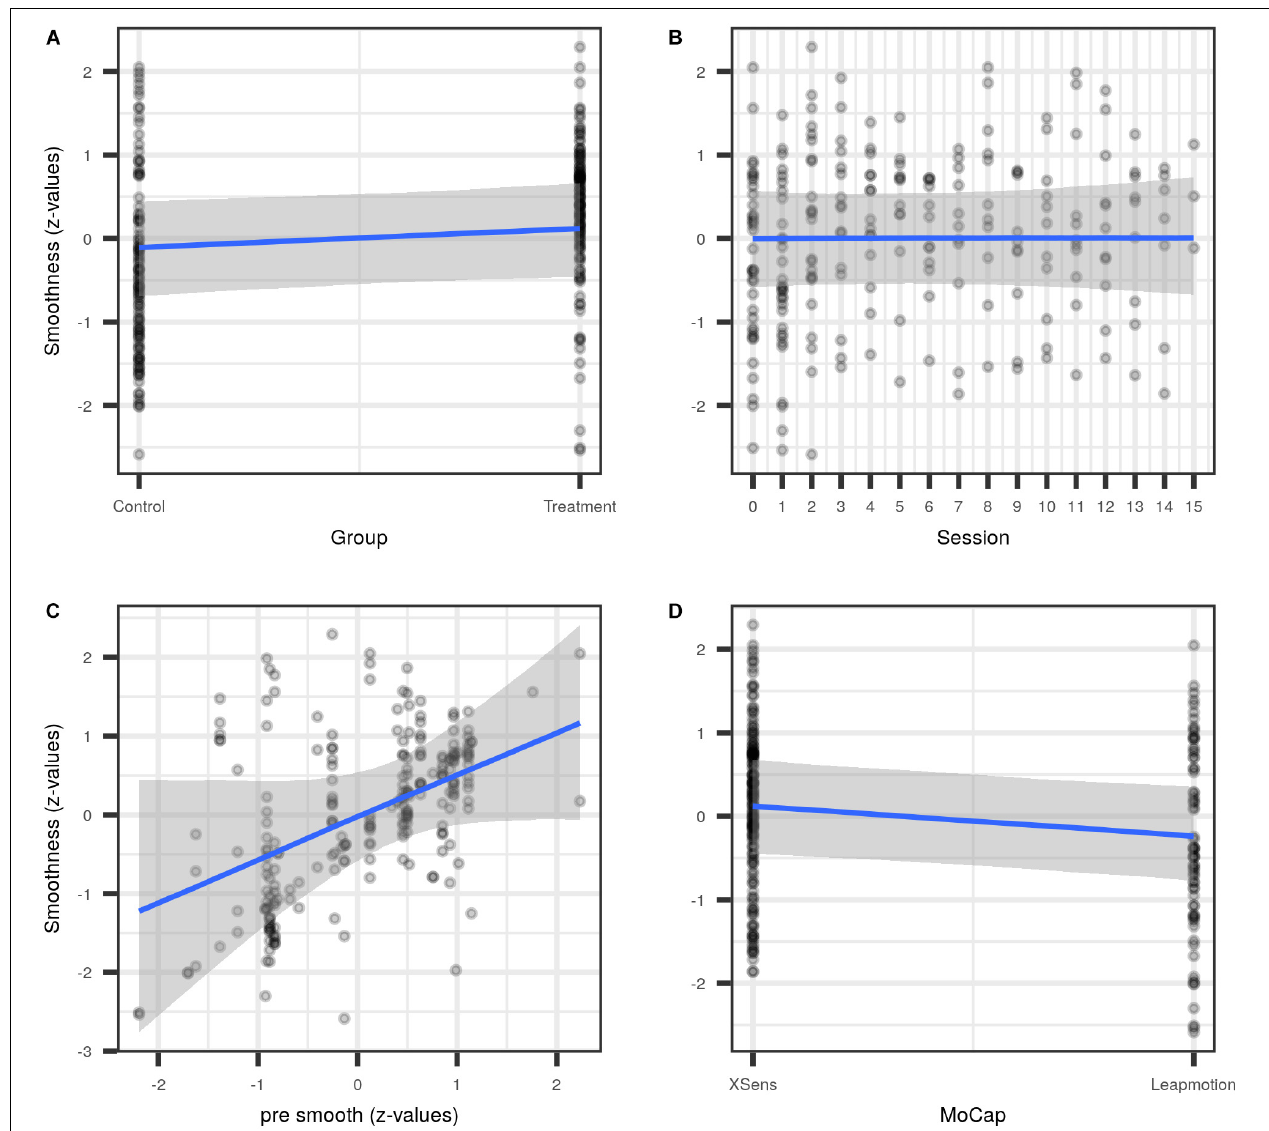
FIGURE 5 | Conditional plots for model #5. Population effects for the covariates Group (A) , medianized session (B) , standardized pre-intervention smoothness pre smooth (C) , and the motion capturing system MoCap (D)